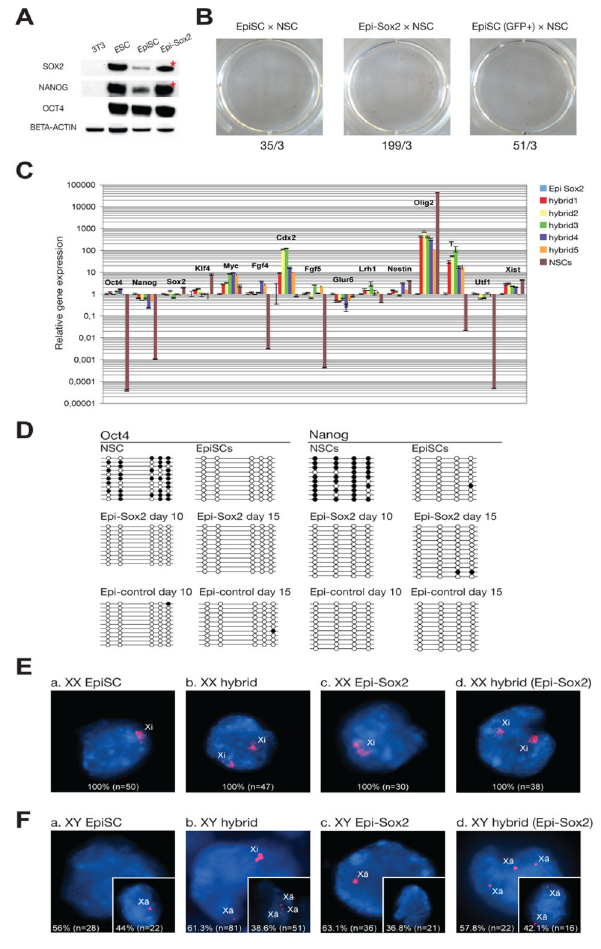
Figure 5. Sox2 overexpression rescues the low reprogramming potential of EpiSCs. ( A ) OCT4, NANOG, and SOX2 protein levels were determined in Sox2- overexpressing EpiSCs (Epi-Sox2) by Western blot. ( B ) Epi- Sox2 showed increased colony-forming rates. Data is represented as the number of total colonies from 3 different experiments. ( C ) The expression profiles of pluripotency and NSC markers in Epi- Sox2 hybrids were assessed by real-time RT-PCR. All data are normalized to Bact expression and calibrated to EpiSCs, whose expression is considered 1 for all genes. The y -axis value is on logarithmic scale, and minor gridlines are 1/10th the value of each major gridline. Data is represented as mean +/- SEM. ( D ) DNA methylation state of Oct4 and Nanog promoter regions in control hybrids and Epi- Sox2 hybrids was compared by bisulfite sequencing. Open and filled circles indicate unmethylated and methylated CpGs, respectively. ( E and F ) X chromosome state was determined by Xist / Tsix RNA FISH in XX ( E ) and XY ( F ) EpiSC hybrids and